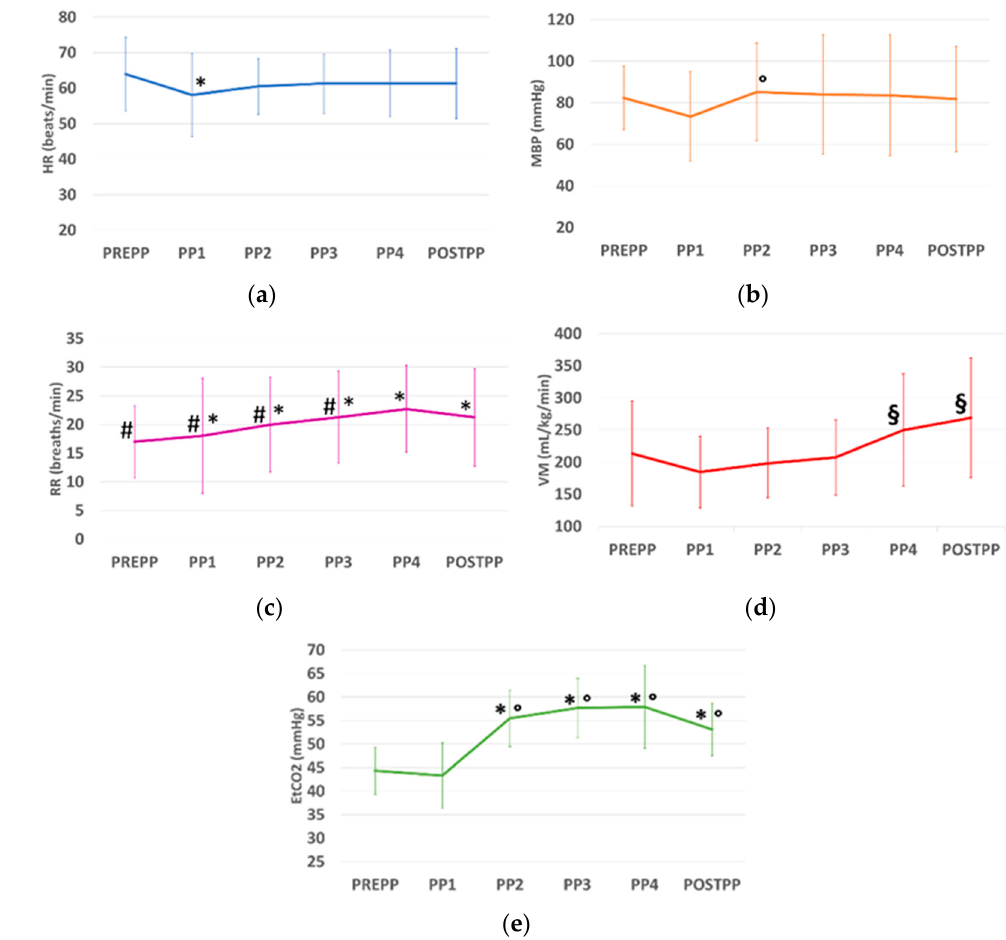
Figure 1. The figures show the mean ± standard deviation (SD) of HR ( a ), MAP ( b ), RR ( c ), MV ( d ), and EtCO 2 , ( e ) during the times of the study. * = p < 0.05 compared to PREPP. # = p < 0.05 compared to PP4. ° = p < 0.05 compared to PP1. § = p < 0.05 compared to PREPP, PP1, PP2, and PP3. The SpAT measured prior to induction ranged between 86% and 99% (mean of 93%, 95% CI 88–98), and that measured post-LMA removal was between 93% and 99% (mean of 97%, 95% CI 95–100). The data referring to SpAT are not available for all of animals